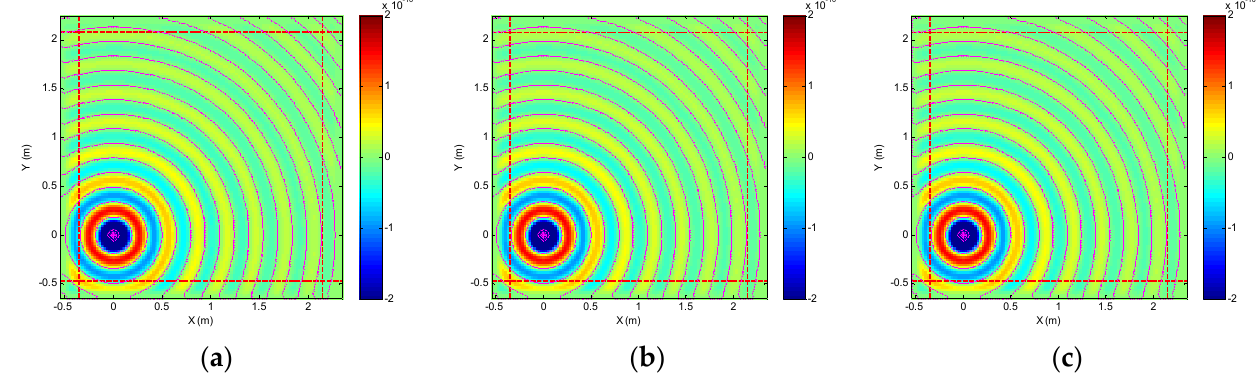
Figure 3. Process from the time ‐ to the frequency ‐ domain by the Fourier transform, and the cross ‐ section diagram at the frequency point f = 1 GHz when n t = 4000: ( a ) Z = 0 m, ( b ) Z = 1 m, ( c ) Z = 2 m.